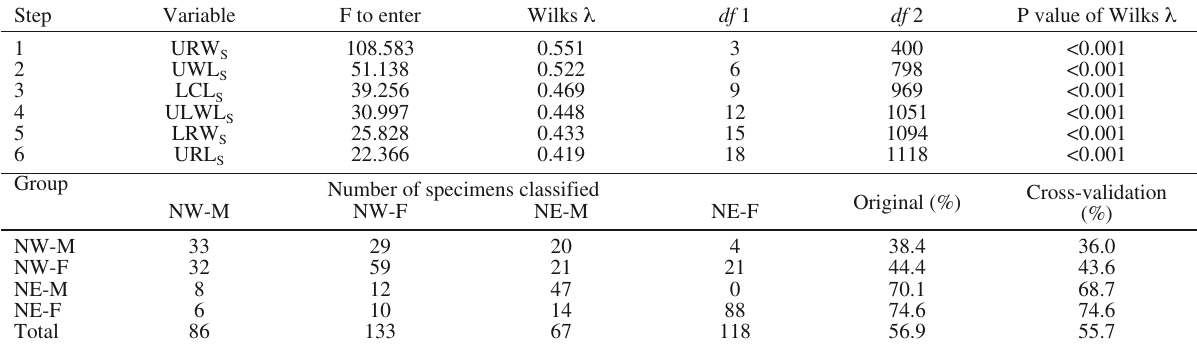
Table 4. – The results estimated fromstepwise discriminant analysis of standardized beak variables for each sex of two populations, and a classification matrix with percentages of correctly classified individuals and cross-validation results.